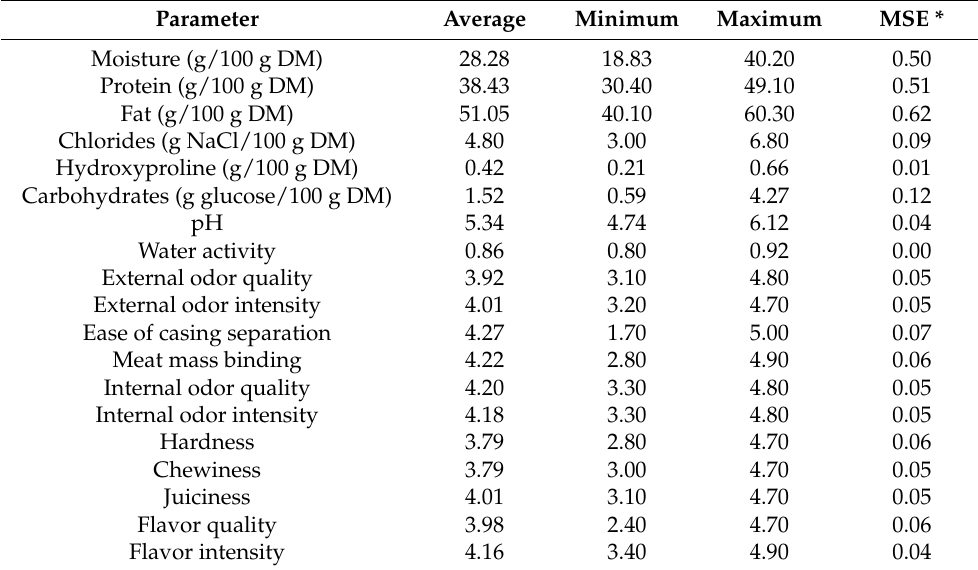
Table 2. Results of the physicochemical and sensory analysis of dry-fermented sausages of the “Chorizo Zamorano” quality